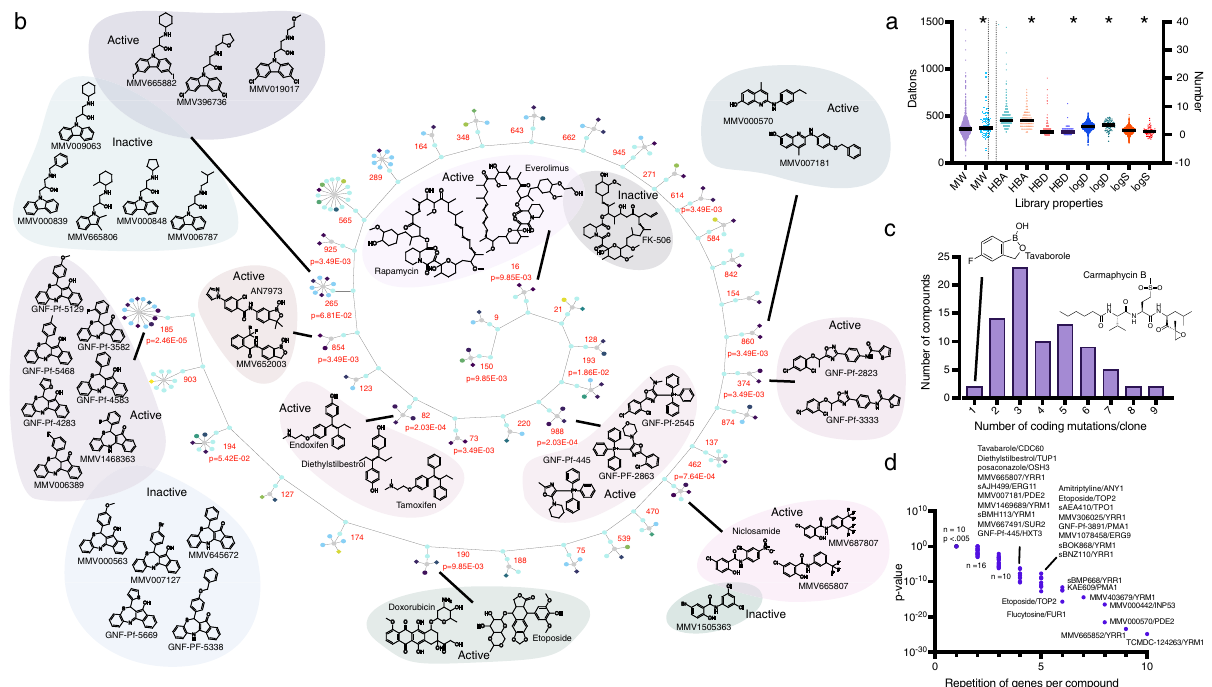
Fig. 1 Compound summary. a Lipinski properties. Lipinski ’ s properties of compounds used in this study were calculated using StarDrop version 6.6.4. Left Y -axis: MW molecular weight: Right Y -axis: HBD hydrogen bond donor, HBA hydrogen bond acceptor, logD, logS. * indicates 80 compounds that yielded resistant clones. b Maximum Common Substructure (MCS). Structure similarity clustering analysis for 80 compounds yielding resistant clones and larger library of 1600, using Tanimoto as the similarity metric. The diagram shows 41 clusters sharing an MCS from which at least one compound was selected for drug response (indicated by diamonds). Circles represent compounds that were not selected, or inactive. The strength of cytotoxicity against the S. cerevisiae GM strain of tested compounds is indicated by the node ’ s color intensity from purple (higher potency) to yellow (lower potency). Probability values were calculated using the hypergeometric mean function showing that enrichment for clusters was greater than expected by chance. Compounds from clusters with a p -value of less than 0.05 and which had multiple members active against GM are shown. c Coding region mutations for selected compounds. Histogram showing the distribution of the number of coding mutations (e.g., missense, start-lost) per clone for the set of 80 compounds used in selections. d Gene enrichment for selected compounds. The p -value is the probability of repeatedly discovering the same gene for a given compound, calculated using Bonferroni-corrected hypergeometric mean function as described in Methods. Compound/gene pairs for n = 1, 2, and 3 can be obtained from Supplementary Data